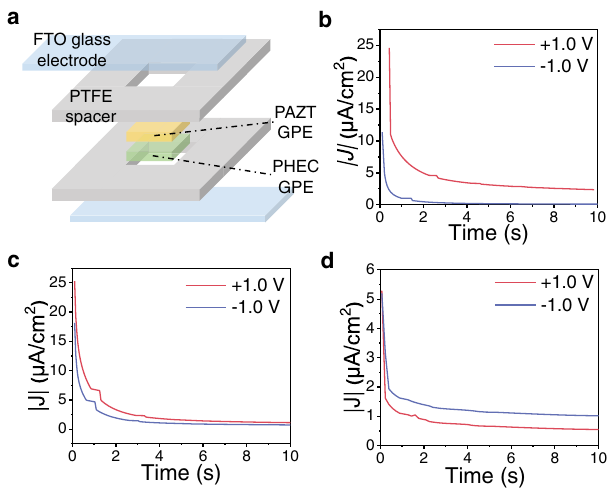
Fig.2|StructureandtransientcurrentresponsesofGPEionicdiode.a GPEionic diode in sandwich structure; b transient current response of PAZT/PHEC hetero- junction at ±1.0V; c PHEC/PHEC homojunction at ±1.0V; d PAZT/PAZT homo- junction at ±1.0V.